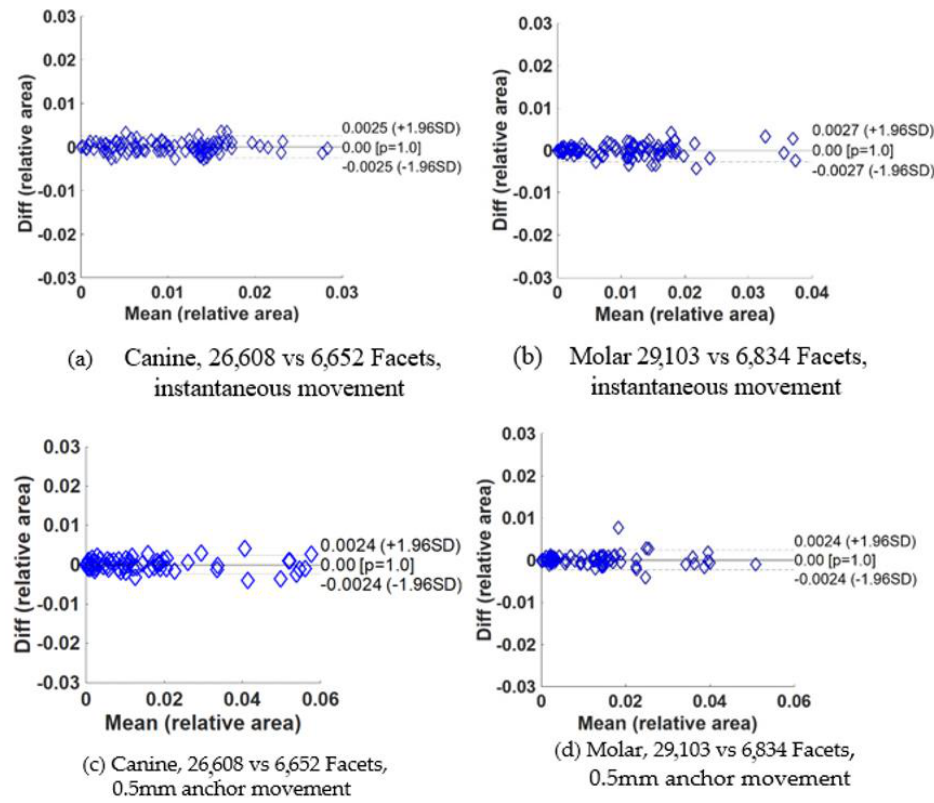
Figure 8. Bland–Altman plots of selected resolutions compared to the highest resolution. Values provided in units of SD.